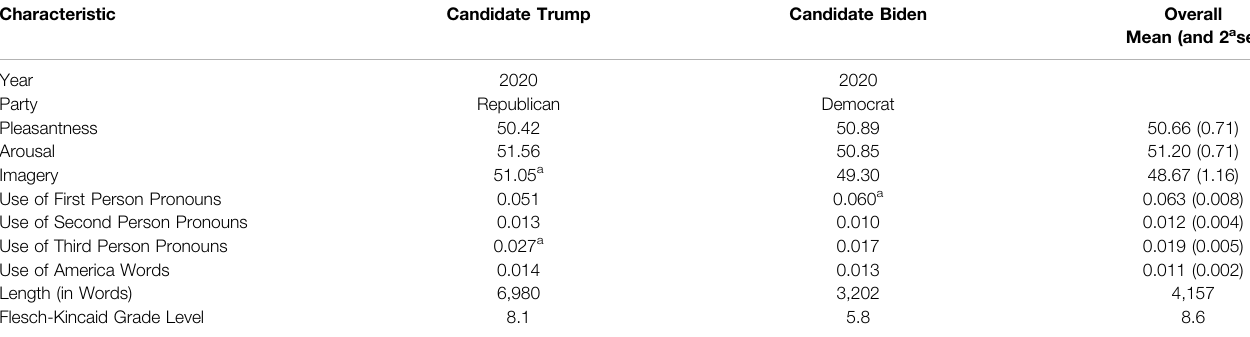
TABLE 1 | Means for all speech characteristics for the two most recent presidential nomination acceptance addresses: Trump and Biden, 2020.